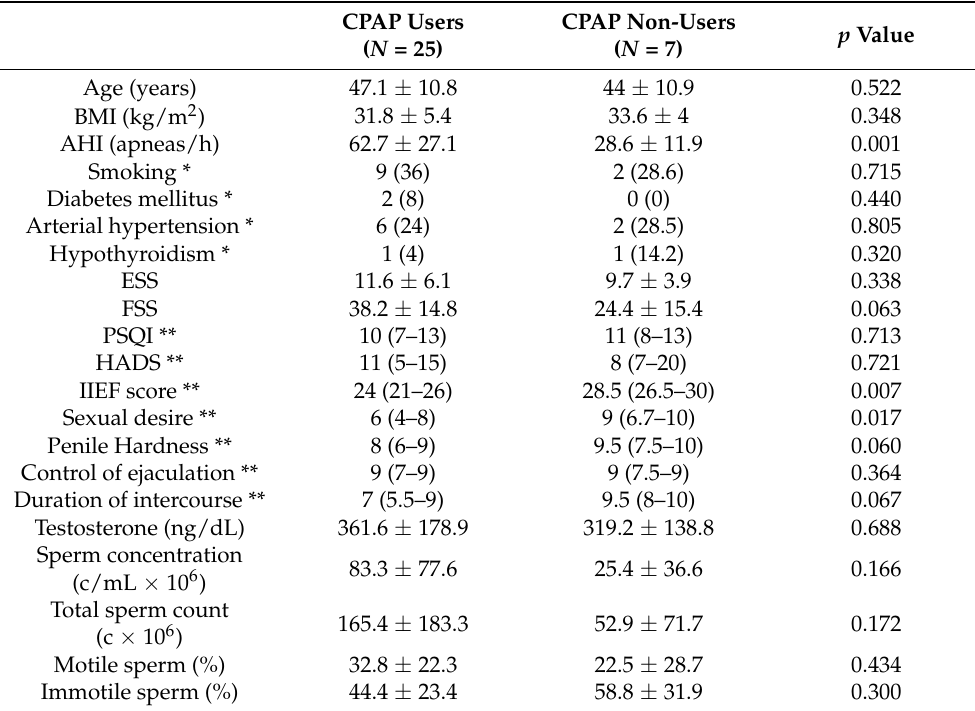
Table 4. Clinical characteristics of the two groups of OSA patients, according to CPAP use. Mean ± SD, unless otherwise specified.